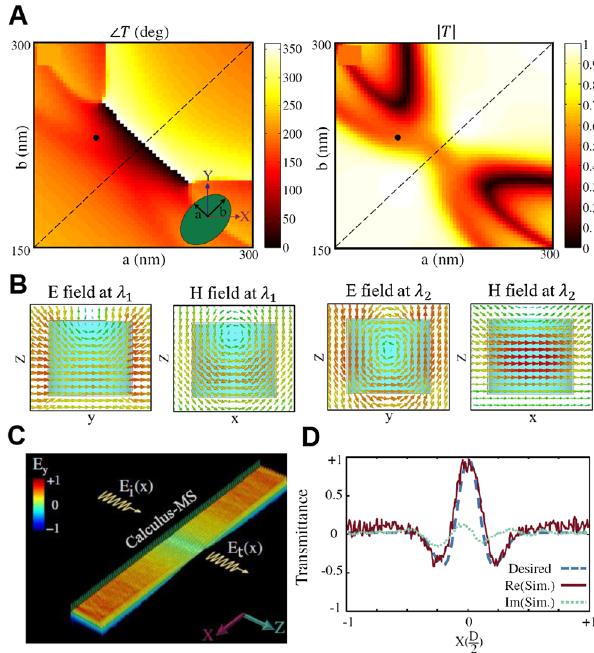
Figure 6: All-dielectric metasystems as equation solvers [39]. (A) Numerically calculated phase and amplitude of transmitted light from the computational metasurface as a function of minor and major axis dimension. (B) Simulated electric and magnetic lines in the cross section of a silicon (Si) nanodisk at the electric and magnetic resonances fulfilled at structural parameters associated with the dots shown in (A). (C) Snapshot of the y -component of the simulated electric fi eld propagating through the computational metasurface realizing the kernel for solving the integrodifferentiation equation. (D)Comparisonassessmentbetweenthenormalizedelectricfieldat the output of the proposed metalens/computational metasurface/ metalens system and analytical results for integrodifferential equation